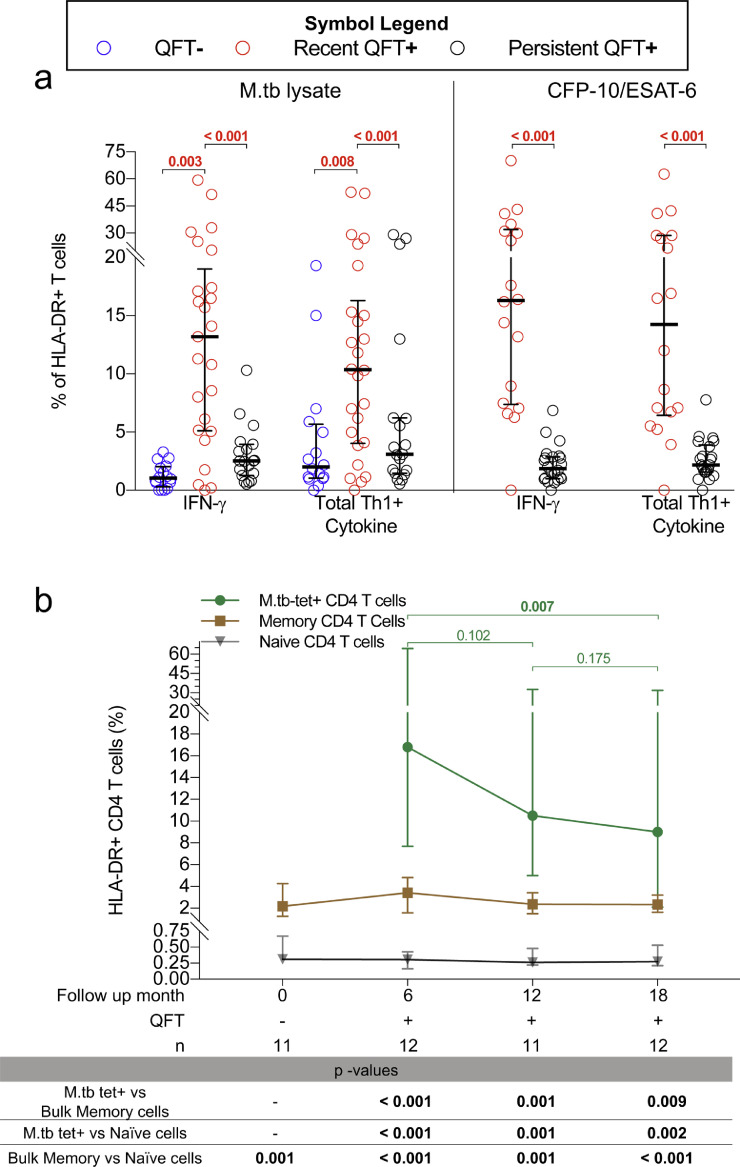
Recent QFT+ is associated with higher levels of T cell activation than persistent QFT+. (a) Graphs depict proportions of HLA-DR+ CFP-10/ESAT-6- and M.tb lysate-specific IFN-γ+ or Total Th1 cytokine+ (IFN-γ±TNF±IL-2±) CD4 T cells before (QFT−, blue, M.tb lysate: n= 16), after (recent QFT+, red, CFP-10/ESAT-6: n=18; M.tb lysate: n= 25), and during persistent M.tb infection (persistent QFT+, black, CFP-10/ESAT-6: n=22; M.tb lysate: n=19). Statistical analysis was conducted as in Fig. 2. (b) Proportions of HLA-DR+ M.tb-specific tetramer+ (green), bulk naïve (grey, CD45RA+CCR7+CD27+CD95-) and bulk memory (brown, non-naïve T cells) CD4+ T cells are represented by median (symbol) and IQRs (bars) in recent QFT+ (tetramer cohort, Month 0: n = 11; Month 6: n=12; Month 11: n=17; Month 18: n=12) individuals. Some individuals were stained with more than one tetramer. P-values for (b) were calculated with the Wilcoxon signed-rank test. P-values <0.016 (for a) and < 0.05 (for b), highlighted in bold were considered significant.